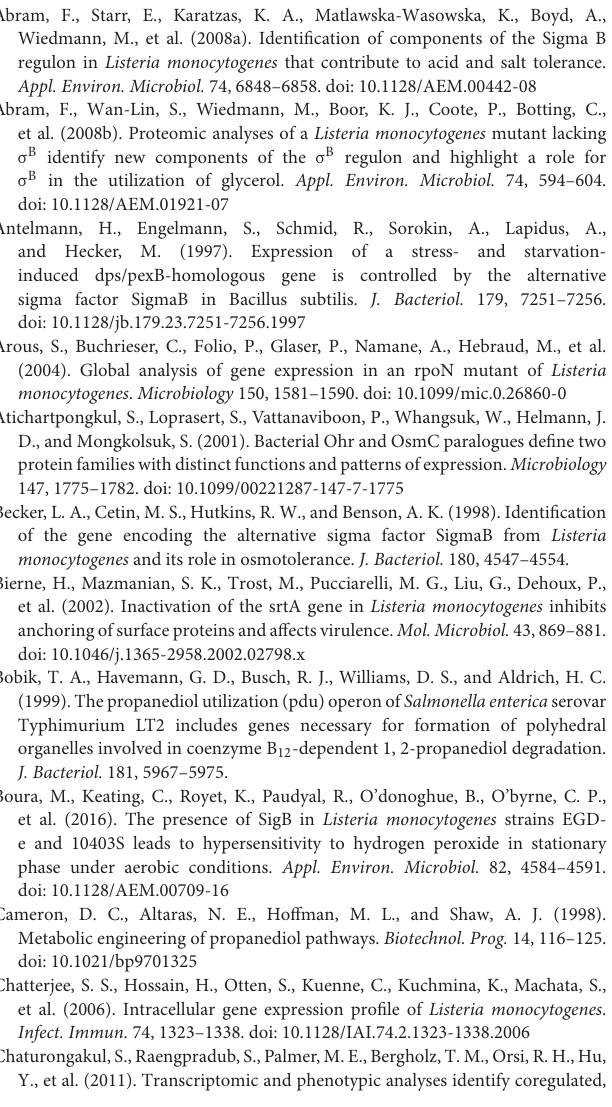
Supplementary Table 5 | List of NDE σ B -dependent genes. Supplementary Table 6 | 5 ′ UTRs of the NDE σ B -dependent genes. Supplementary Table 7 | TUs with σ B -dependent